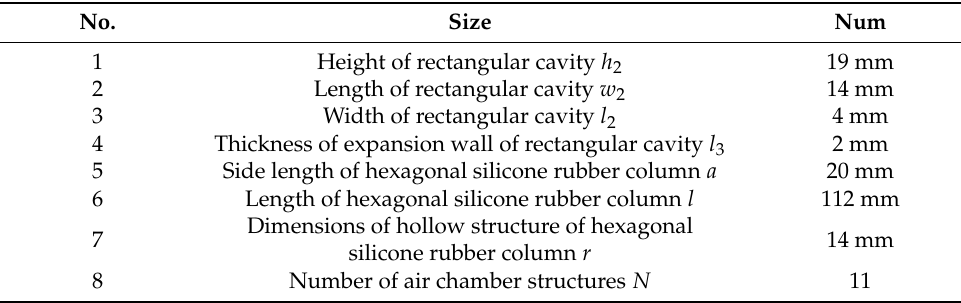
Table 1. Main structural parameters of the actuator.